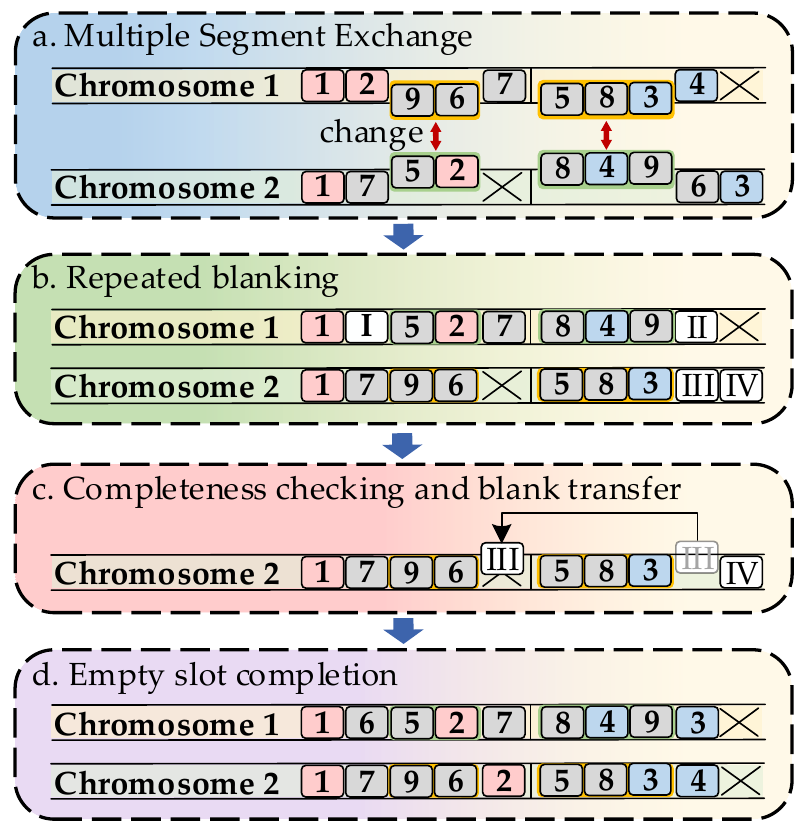
Figure 6. Positive segmented crossover operation step.